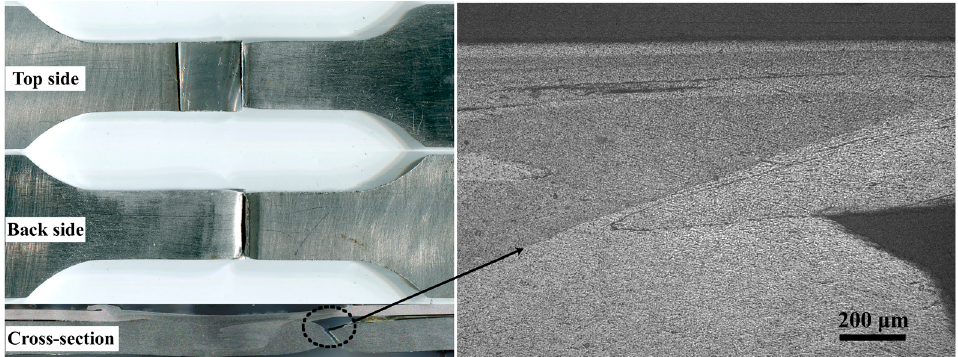
Materials 2019 , 10 , x FOR PEER REVIEW Figure 7. Morphology of the fracture of joints. Figure 7. Morphology of the fracture of joints.